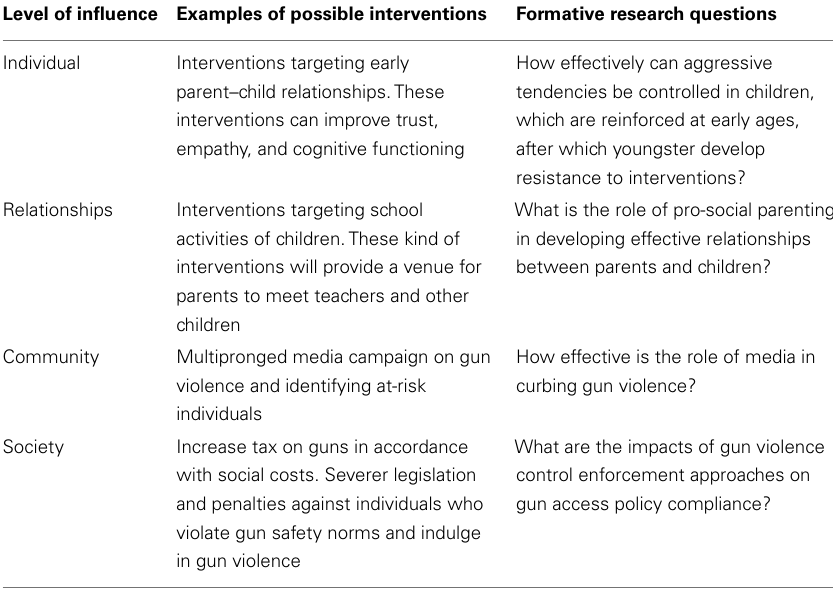
Table 1 | Social ecological model of influence a . Level of influence Examples of possible interventions Formative research